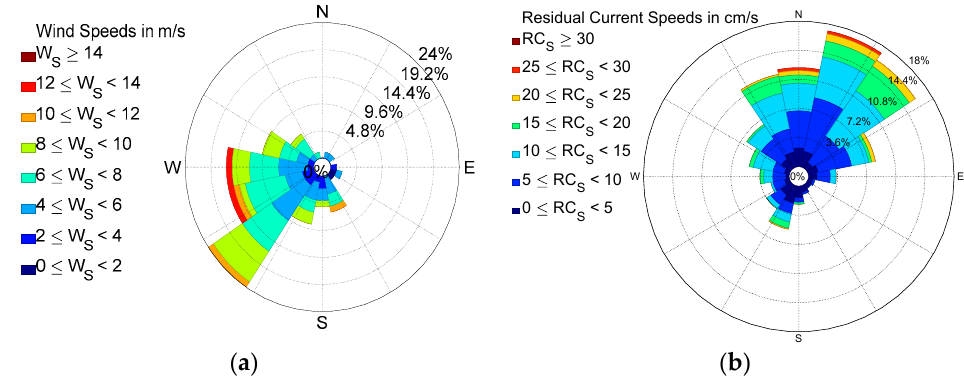
Figure 7. Rose diagram for summer. ( a ) wind; ( b ) residual currents.